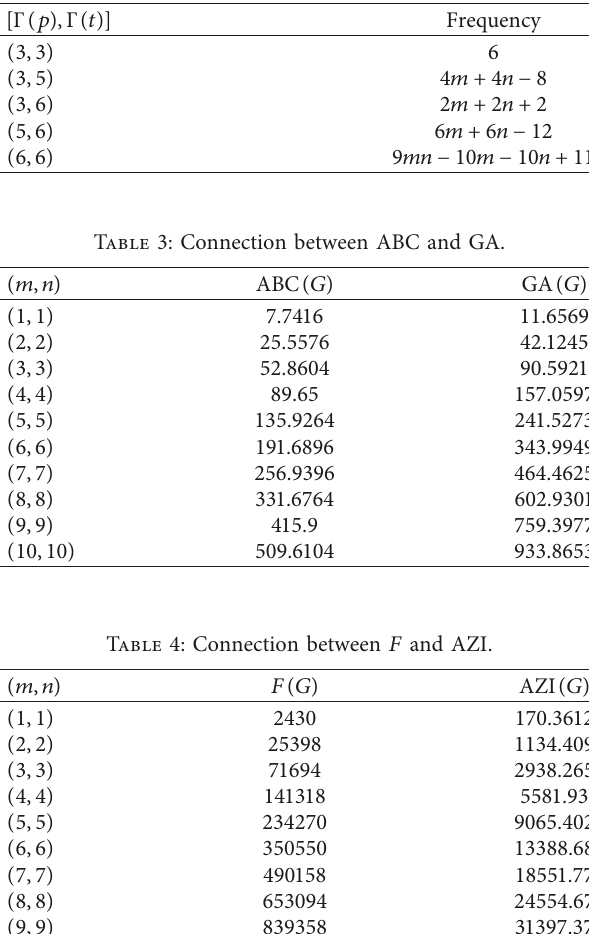
( G ) , R ( G ) , R ( G ) , and − 1 1 1/2